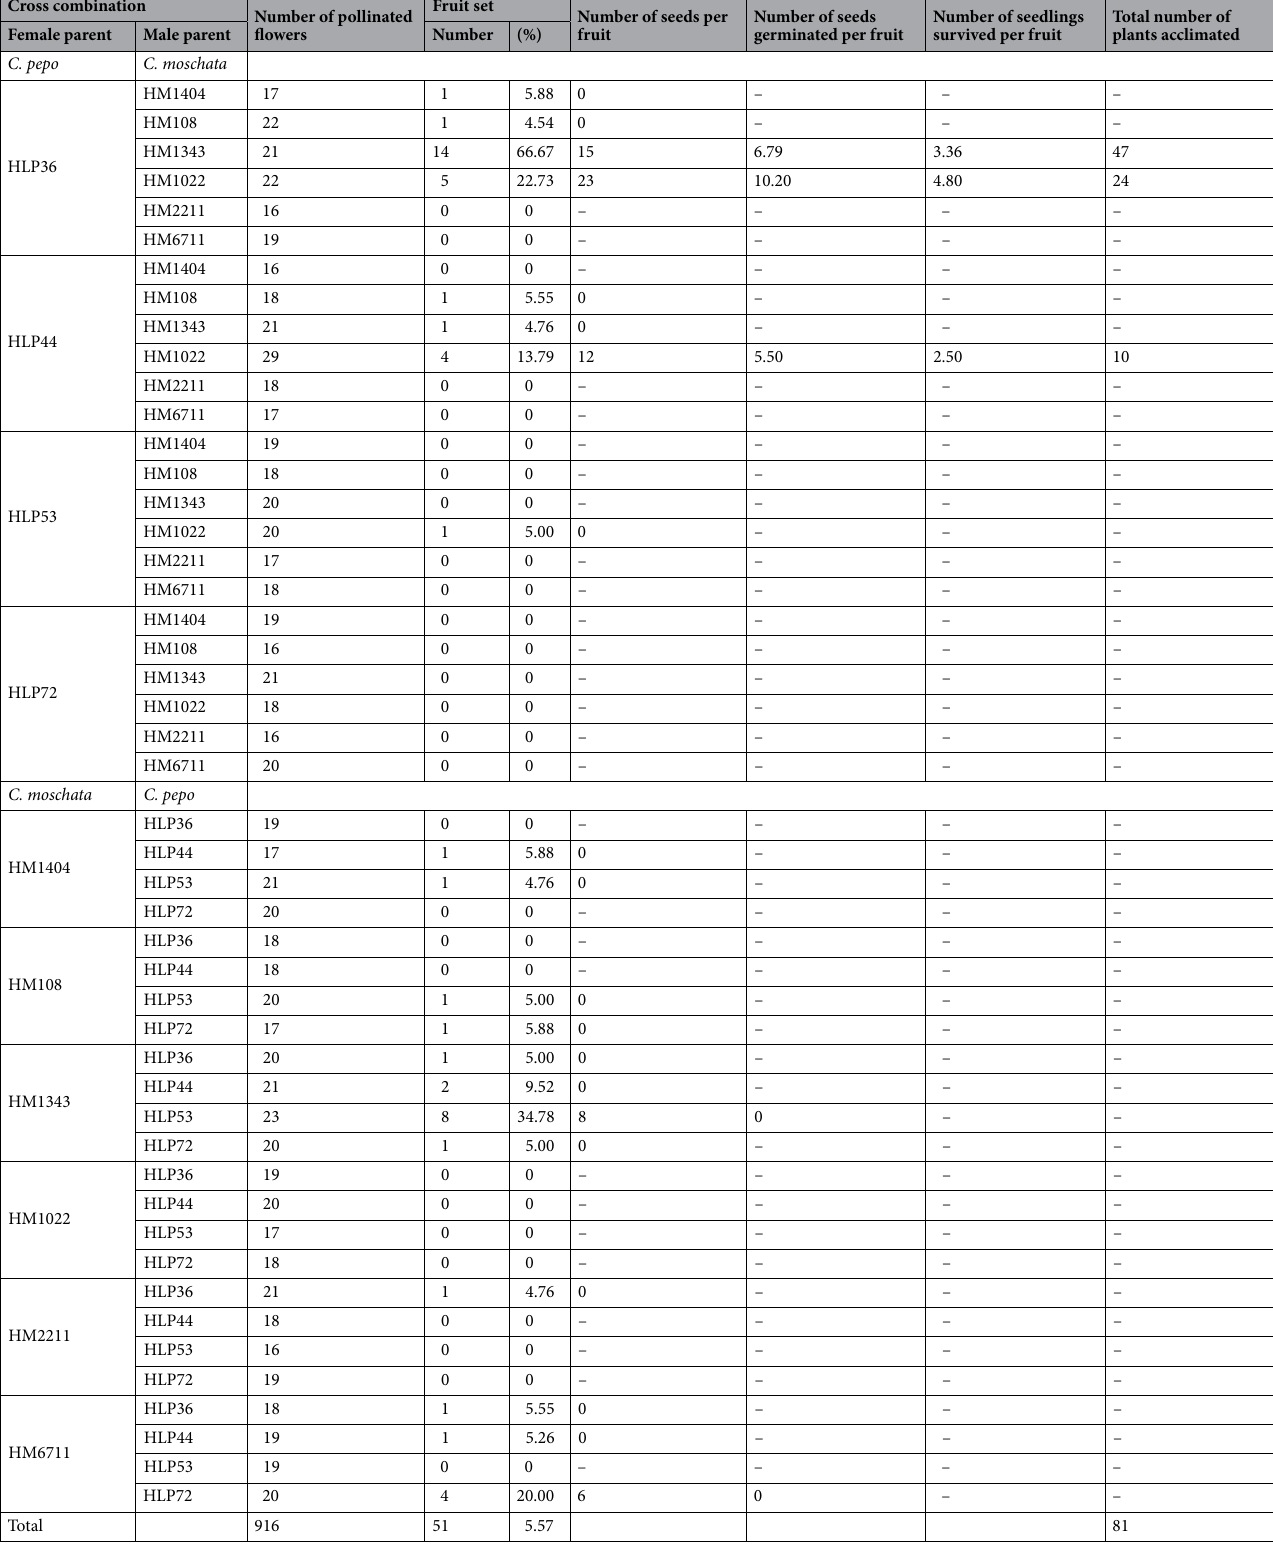
Table 1. Interspecific hybridization between C. pepo × C. moschata and their reciprocal crosses through conventional